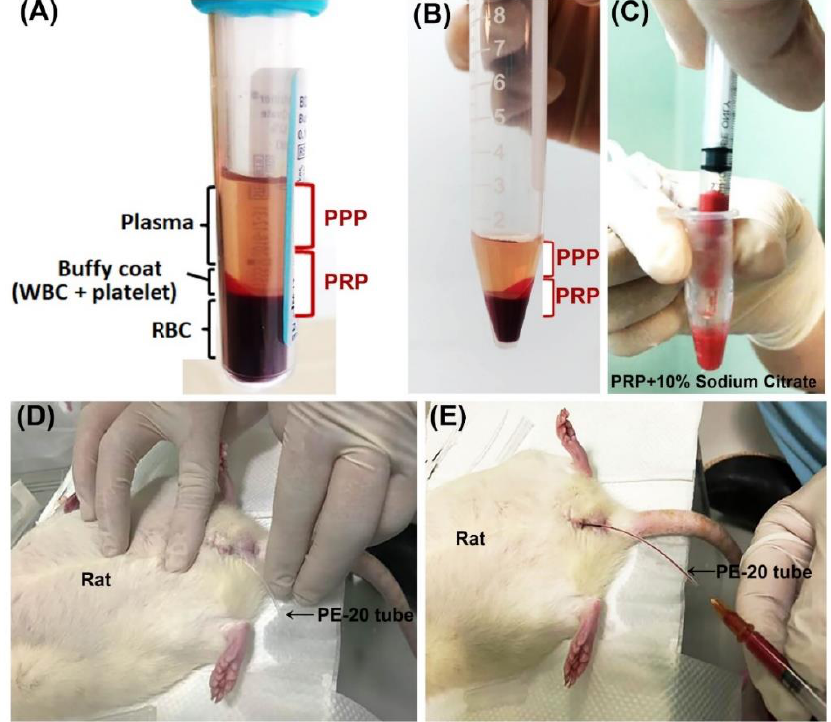
Figure 8. Schematization of platelet-rich plasma (PRP) preparation and application in rat. Blood was harvested from female rats through tail vein under anesthesia. ( A ) After centrifugation, the collected whole blood was separated into three layers, plasma layer, platelets, leukocytes and red blood cells from top to bottom, respectively. ( B ) After transferred the upper fraction to other new 5 mL vacuum tube and then centrifugation, the upper fraction was separated into platelet-poor plasma (PPP, upper fraction) layer and platelet-rich plasma (PRP, lower fraction). After mixed with 0.1 mL of 10% calcium chloride solution and 0.2 mL of PRP or PPP ( C ), the bladder of the animal was emptied ( D ) and 0.3 of the mixture (calcium chloride solution and PRP or PPP) was injected into bladder by PE-20 tube once per week ( E ).